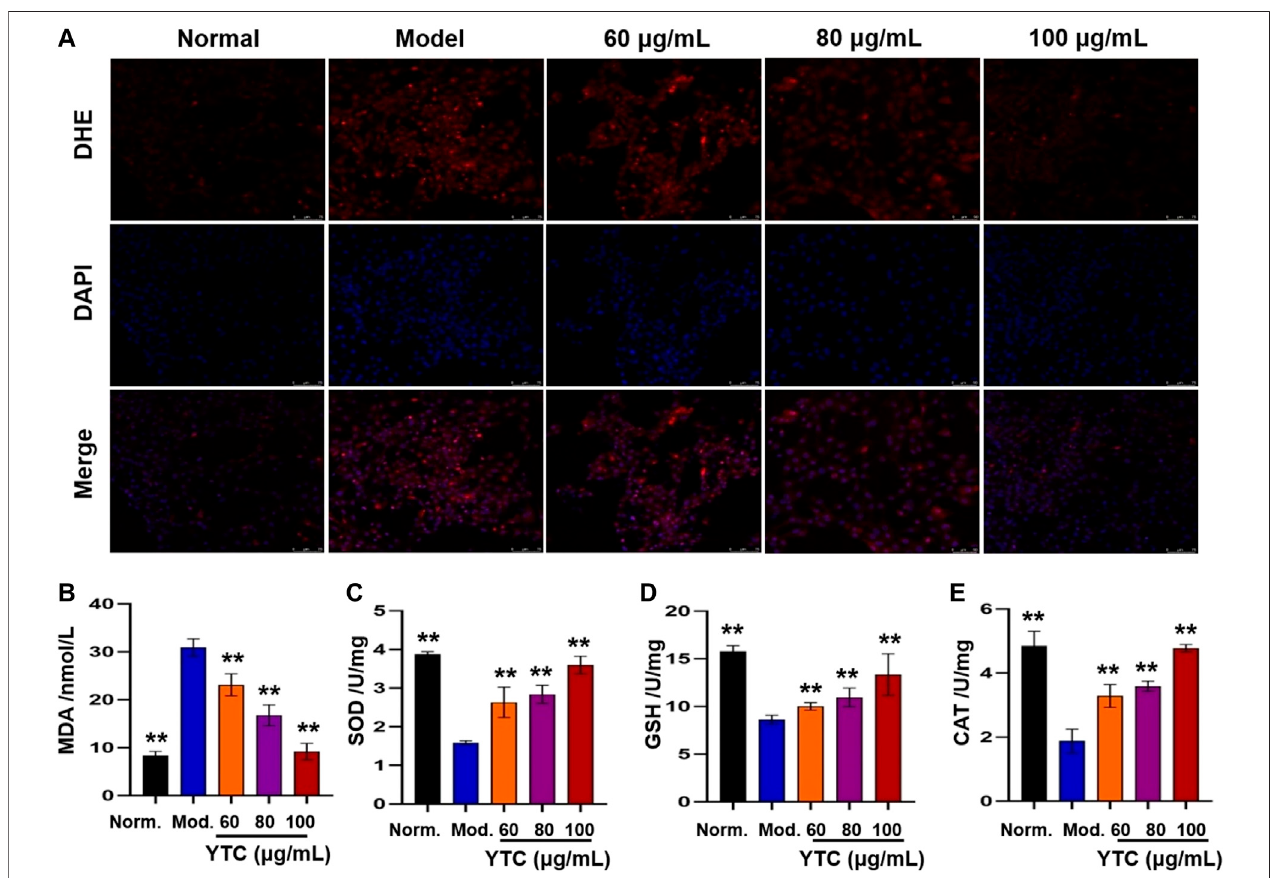
FIGURE 9 | Effects of YTC on ROS levels (A) and antioxidant enzyme activities (B-E) in H 2 O 2 -induced H9c2 cells. H9c2 cells were treated with YTC (60, 80 and 100 μ g/ml) for 24h, and then incubated in the presence ofH 2 O 2 (200 μ M) for4 h (A) TheintracellularROSlevels were observed by laserconfocal microscopy. (B-E) The levels ofMDA and activities ofSOD, GSH-Px, and CAT weredetermined bycommercial assay kits. Thevalueswererepresented asthe mean ± SD ( n = 3). ** p < 0.01 vs the model group.